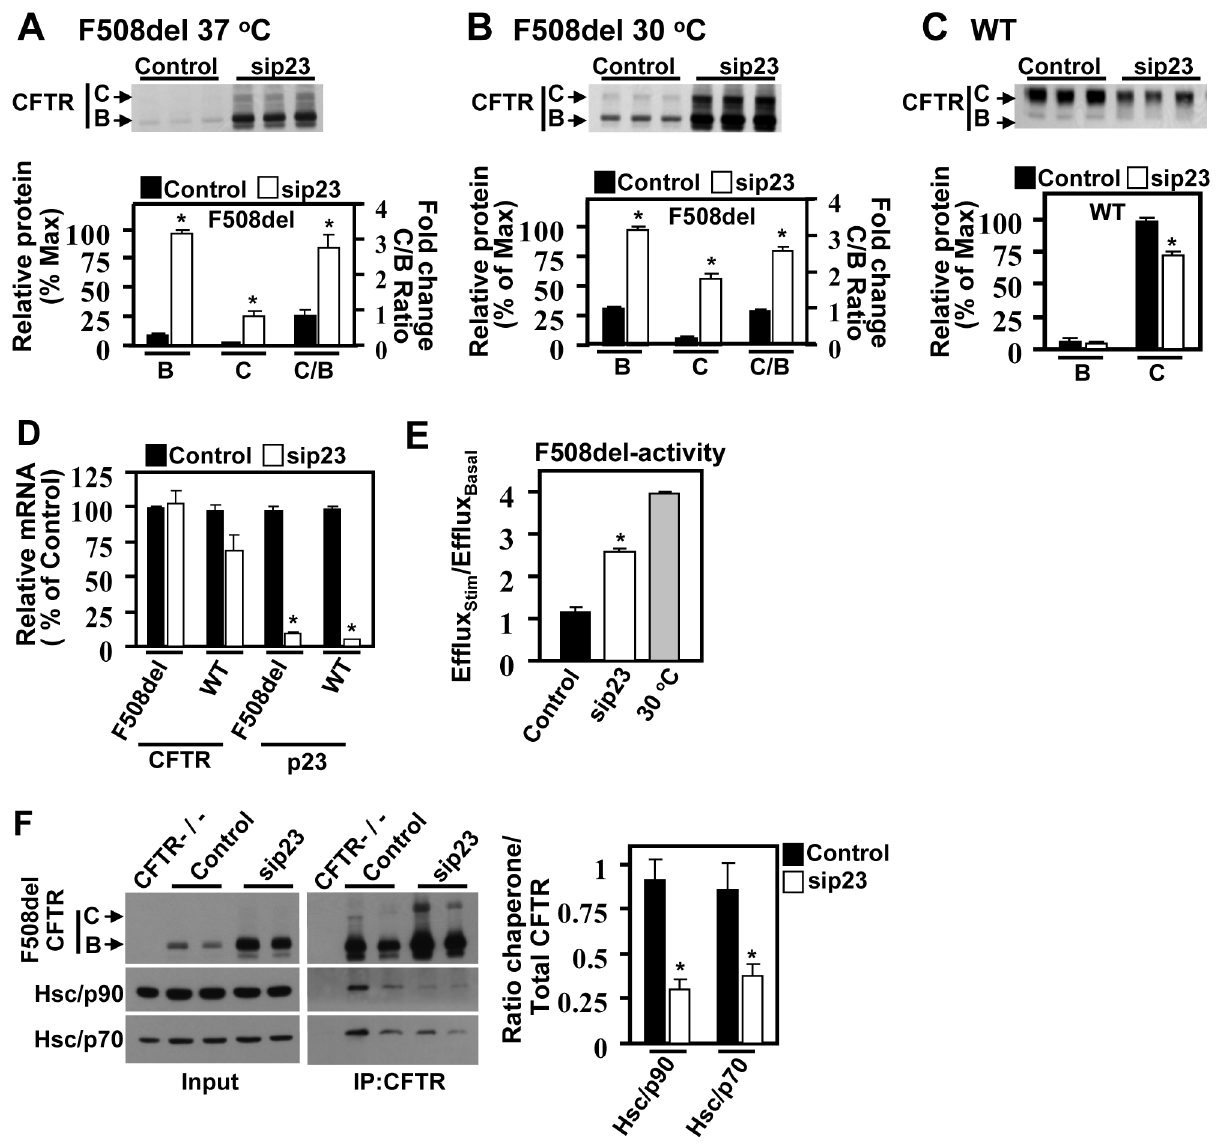
Figure 3. Silencing of p23 improves F508del-CFTR function in CF by down-regulation of the MSR. Immunoblot of CFTR following sip23 treatment of F508del-expressing cells at 37 u C (A) and 30 u C (B) or WT-expressing cells (C). Histograms show quantification of CFTR band-B and C glycoforms and C/B ratios. Results are shown as a percent of the maximal signal for band-B glycoform and as fold change relative to control (set to 1) for the ratio C/B (mean 6 SEM, n $ 3). (D) qRT-PCR analysis of CFTR and p23 levels following p23 silencing in WT or F508del-expressing cells. Results represent a ratio of the indicated mRNA to GUS, and shown as the percent of siRNA control (mean 6 SEM, n $ 3). (E) Iodide efflux analysis of F508del- expressing cells in response to p23 siRNA or 30 u C correction. Results are shown as a ratio of the efflux at stimulation (stim) to efflux at pre-stimulation (basal) (mean 6 SD, n $ 3). (F) Immunoblot of the indicated proteins in the cell lysate (input) or following CFTR IP (right panels) in response to sip23 treatment (CFTR 2 / 2 cells were used as a negative control for the CFTR IP). Histogram shows quantification of recovered Hsc/p90 ( a and b ) and Hsc/ p70 by co-IP with CFTR. The data is shown as a ratio of the recovered chaperone to total CFTR and normalized to 1 for the control siRNA (mean 6 SD, n=3, replicated three times). For all data, * indicates p , 0.05 relative to control, and results were replicated at least once. The underlying data used to make (A–F) in this figure can be found in the supplementary file Data S1.